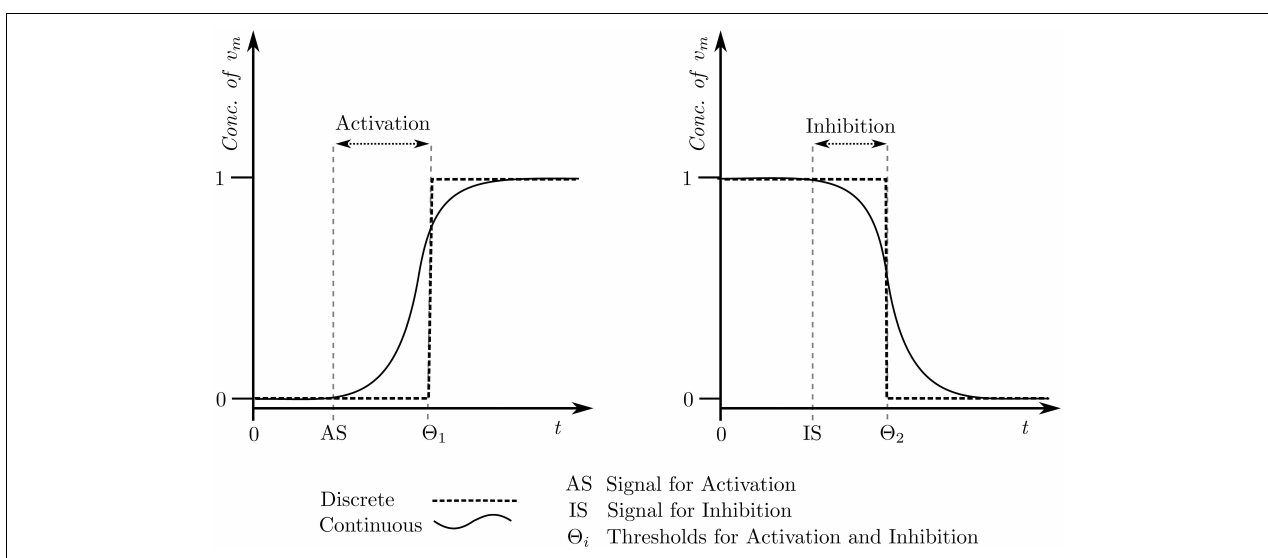
FIGURE 3 | Discrete approximation of the continuous evolution pertaining to concentration of an entity.